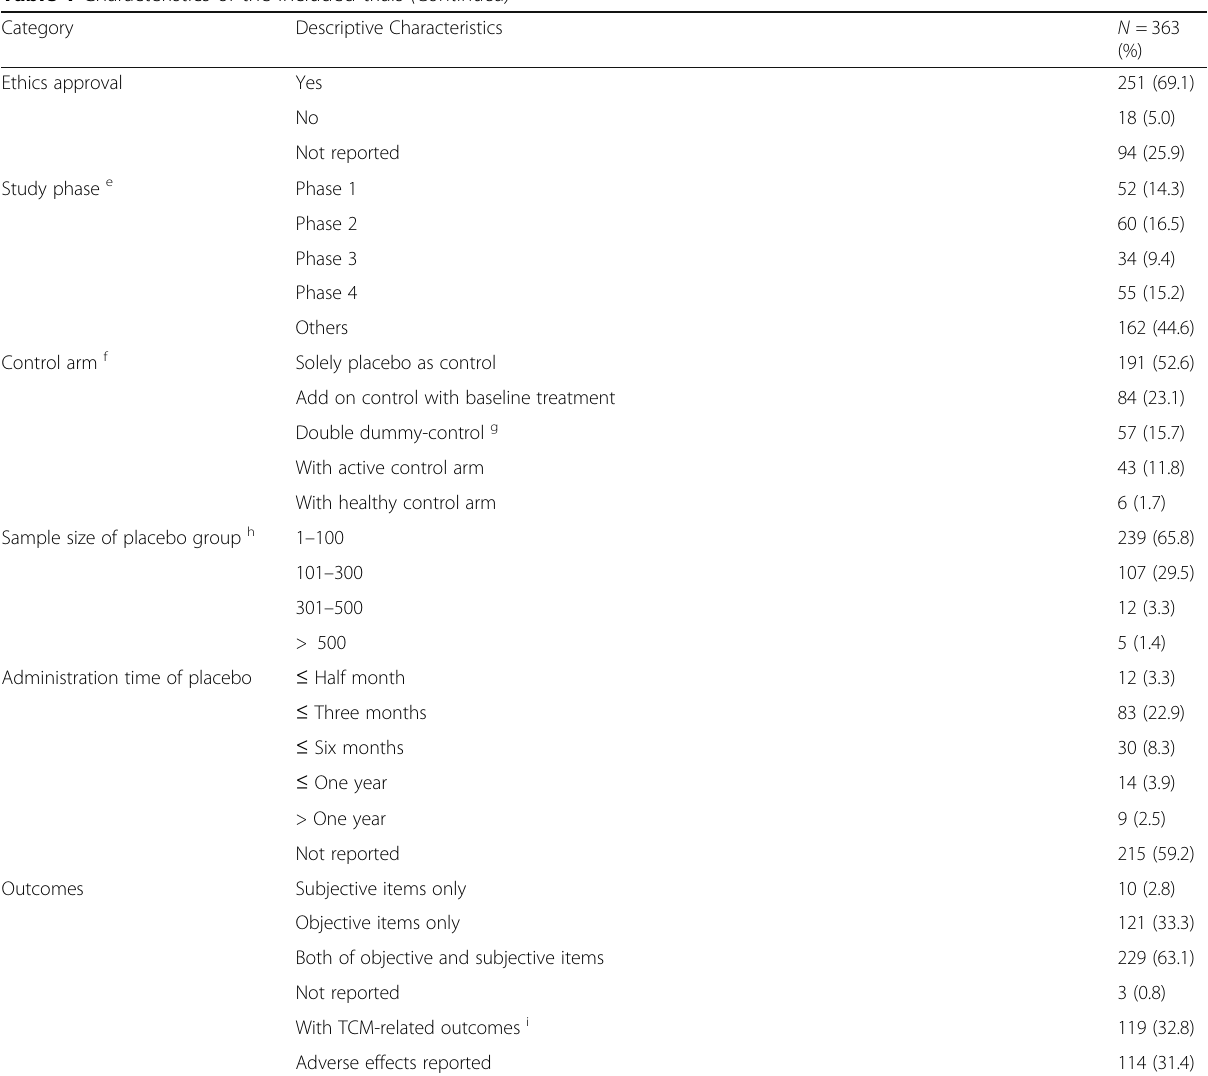
Table 1 Characteristics of the included trials